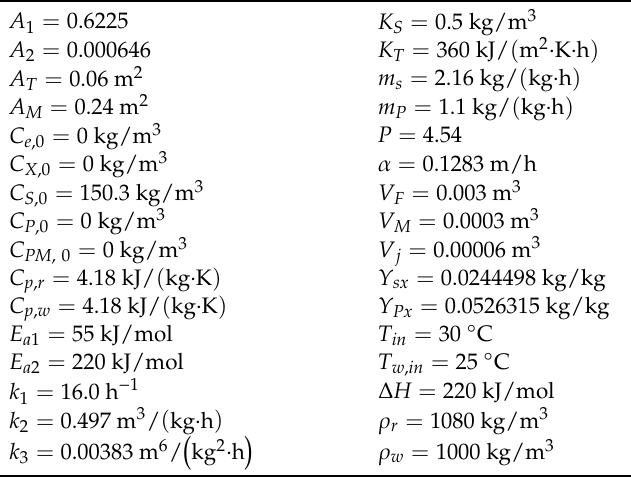
Table A1. Parameter values for the fermentation process